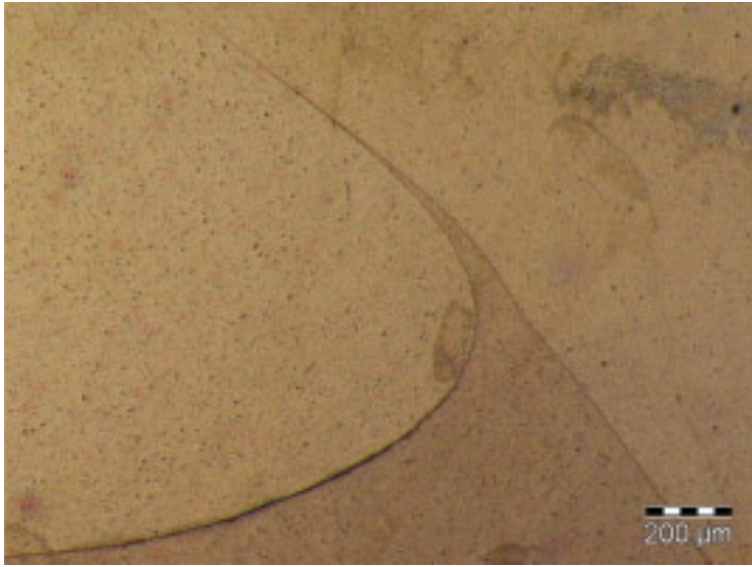
Figure 11. Hook defect of the dissimilar joint (AA5754–AA6082) [82].